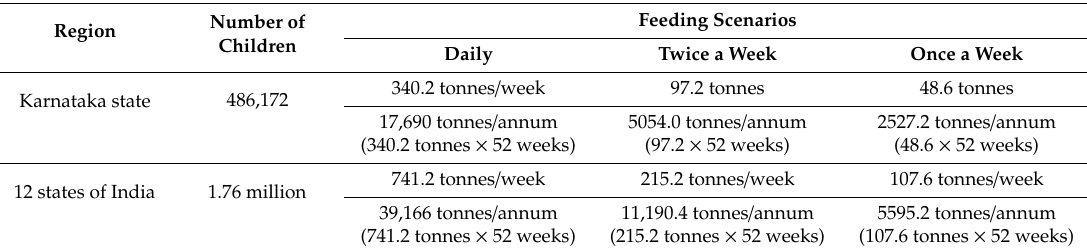
Table 10. Required volume of millets for MDM programs under three di ff erent feeding frequency